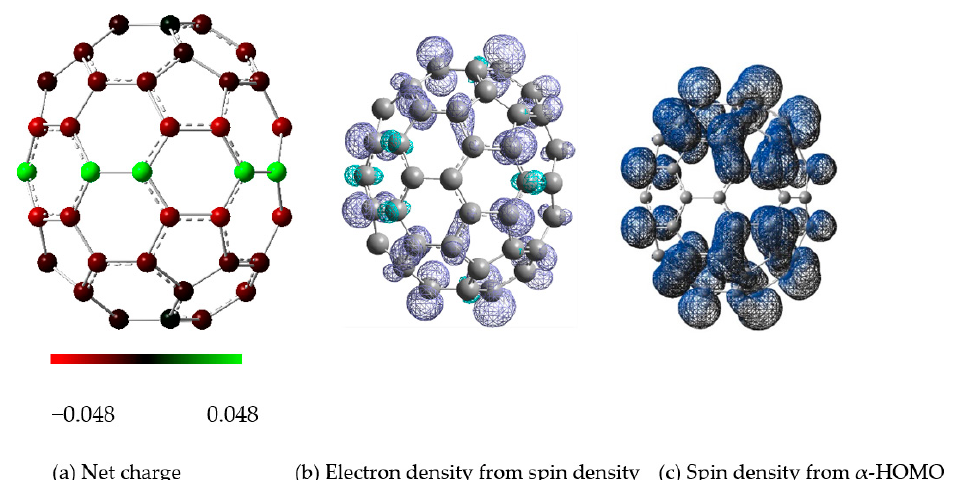
Figure 7. ( a ) Net charge of C 70 − , ( b ) electron density from spin density (= electron density from α - spin density minus electron density from β -spin density) of C 70 − , and ( c ) spin density from α -HOMO for C 70 − showing qualitatively the unpaired electron distributions, in which C 70 − is the optimized structure at the B3LYP/6-31G (d, p) level including the empirical dispersion interaction GD3. In conclusion, first, our manuscript explained the 11 meV energy mode by using the rotation mode of C 70 anion coupling the electric field of gate electrode, by using the total energy difference between different orientation conformers of C 70 which depends on the